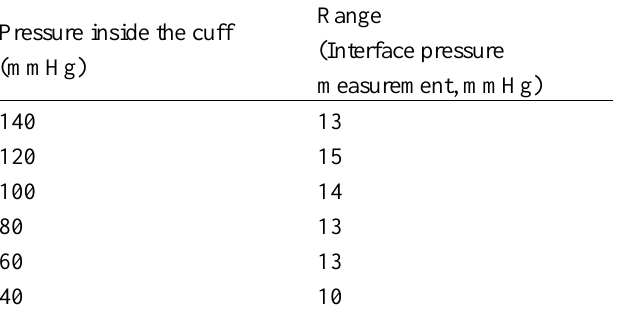
Fig. 5. Average interface pressure against manometric pressure Table 2 Range of interface